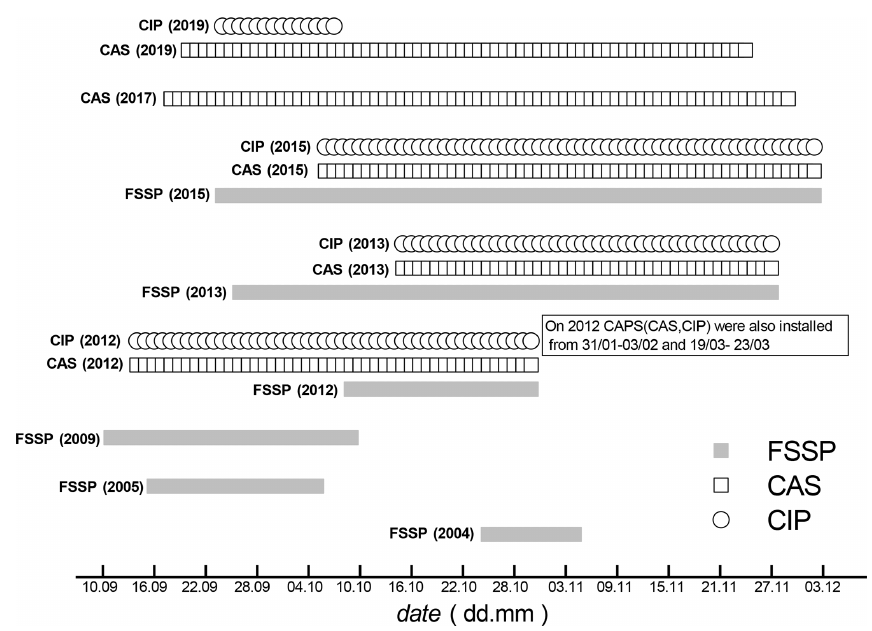
Figure 2. Cloud spectrometer ground setups’ availability during PaCE is presented for each